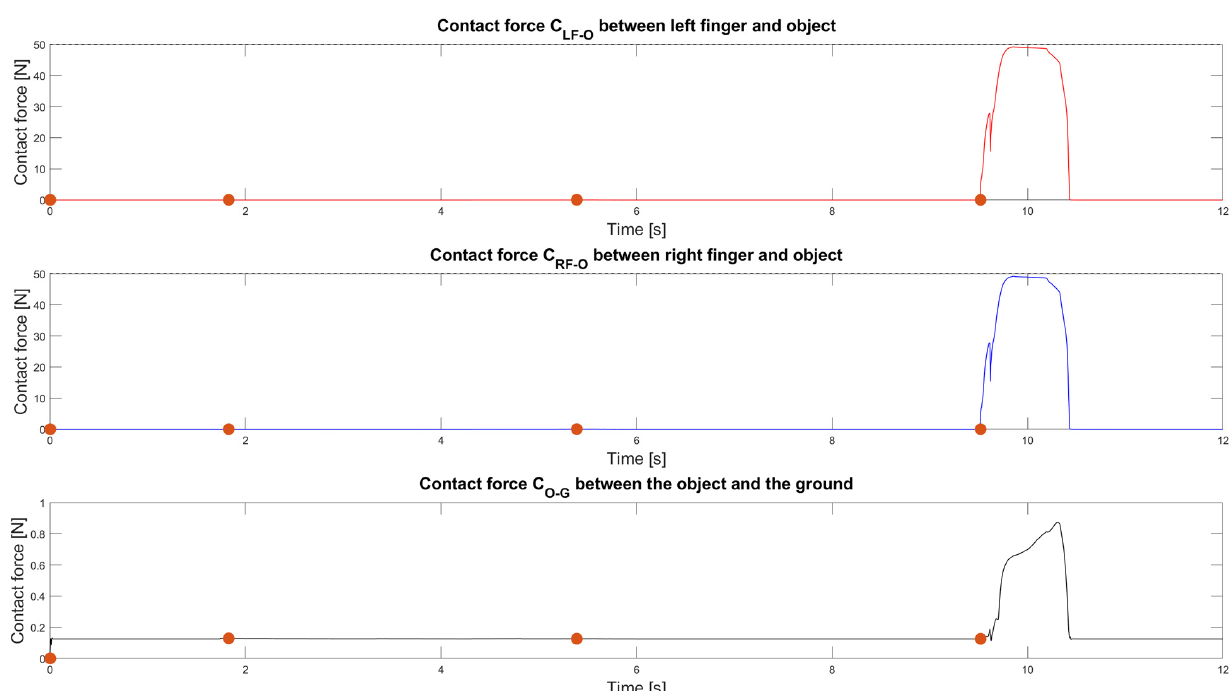
Figure 14. Graphical analysis of the first pick-point. Source: own.